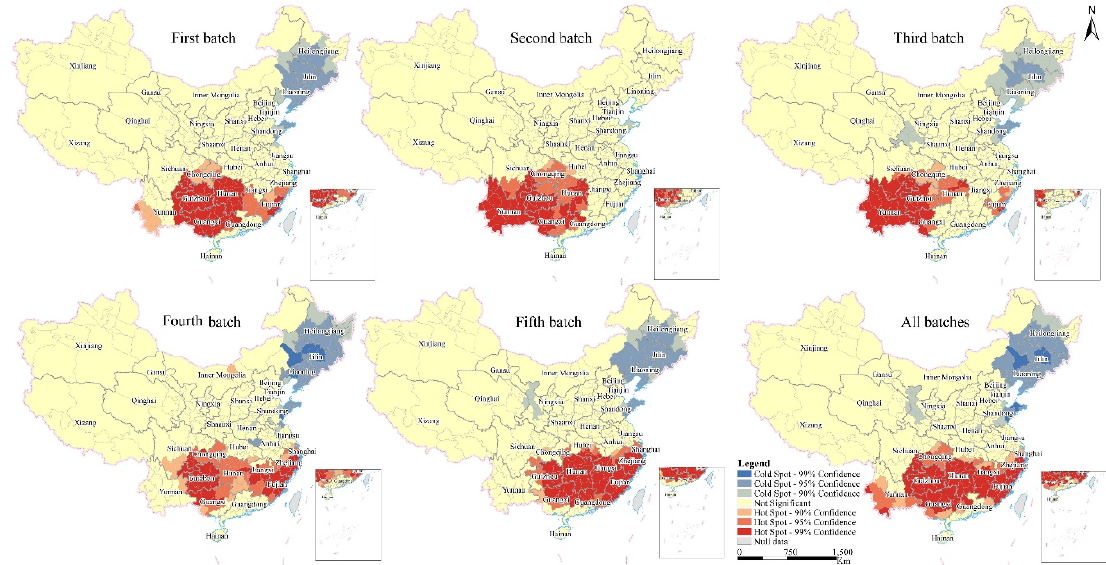
Figure 5. Spatiotemporal hot spot analysis at the city scale.